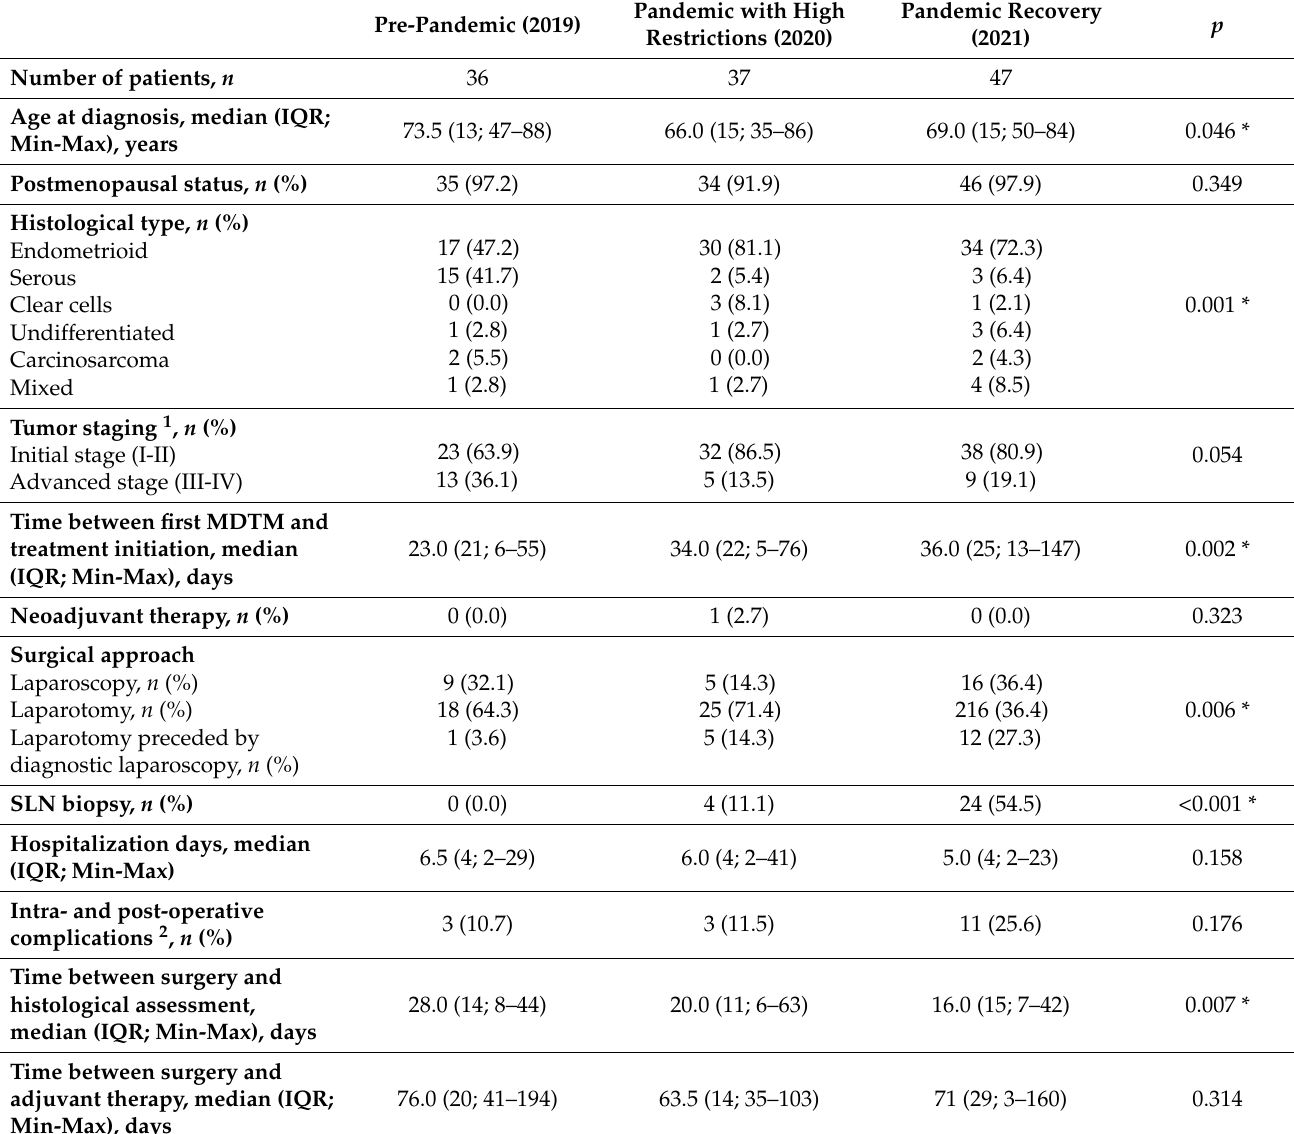
Table 1. Epidemiological, clinical and pathological patterns of patients diagnosed with endometrial cancer ( n =